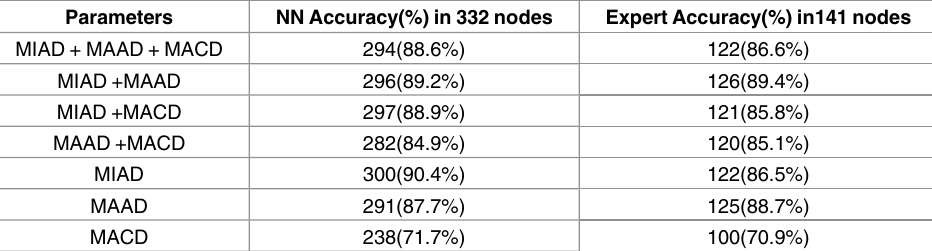
Table 1. Results of NN and expert evaluation for stage I.